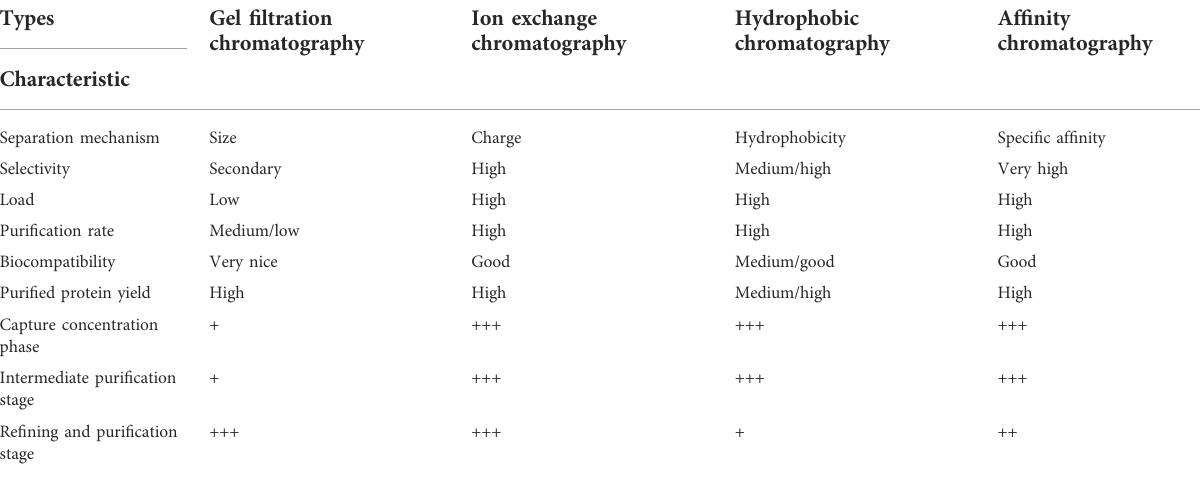
TABLE 5 Comparison of common chromatographic separation